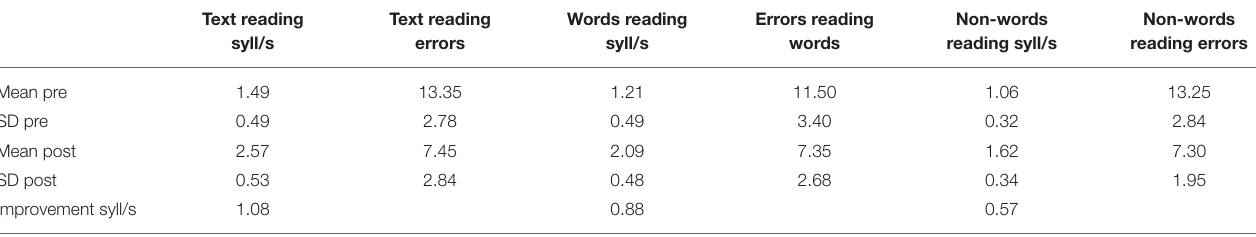
TABLE 1 | Exp 1: Reading raw scores (mean and standard deviation) pre and post treatment; errors number, and syllables per second (syll/s) of text reading MT, words reading DDE-2, and non-words reading DDE-2.